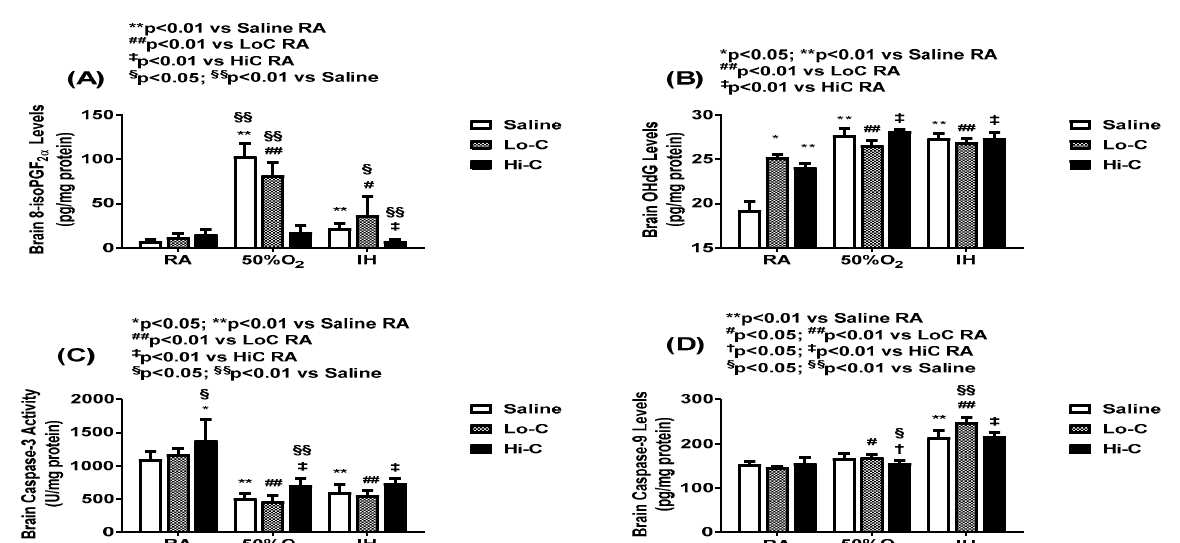
Figure 3. Effect of standard (LoC) and high (HiC) caffeine doses on 8-isoPGF 2 α (panel A ), OHdG (panel B ) and caspase-3 (panel C ), and caspase-9 (panel D ) in the cerebral cortex at P14. Groups are as described in Figure 2. A two-way ANOVA was conducted to examine the effects of oxygen environment (factor 1) and treatment (factor 2) with Dunnett’s 2-sided multiple comparison post hoc test. Saline was used as the control for the treatment groups within each oxygen environment; and room air (RA) was used as the control among the oxygen groups for each treatment. Panel A: F(4,45) = 11.251, p < 0.01; Panel B: F(4,45) = 17.908, p < 0.01; Panel C: F(4,45) = 14.46, p < 0.01; Panel D: F(4,45) = 3.135, p < 0.01. * p < 0.05, ** p < 0.01 vs. Saline RA; # p < 0.05, ## p < 0.01 vs. LoC RA; † p < 0.05, ‡ p < 0.01 vs. HiC RA; and § p < 0.05, §§ p < 0.01 vs. Saline in each oxygen environment. Data are presented as mean ± SEM (n = 6 samples/group).